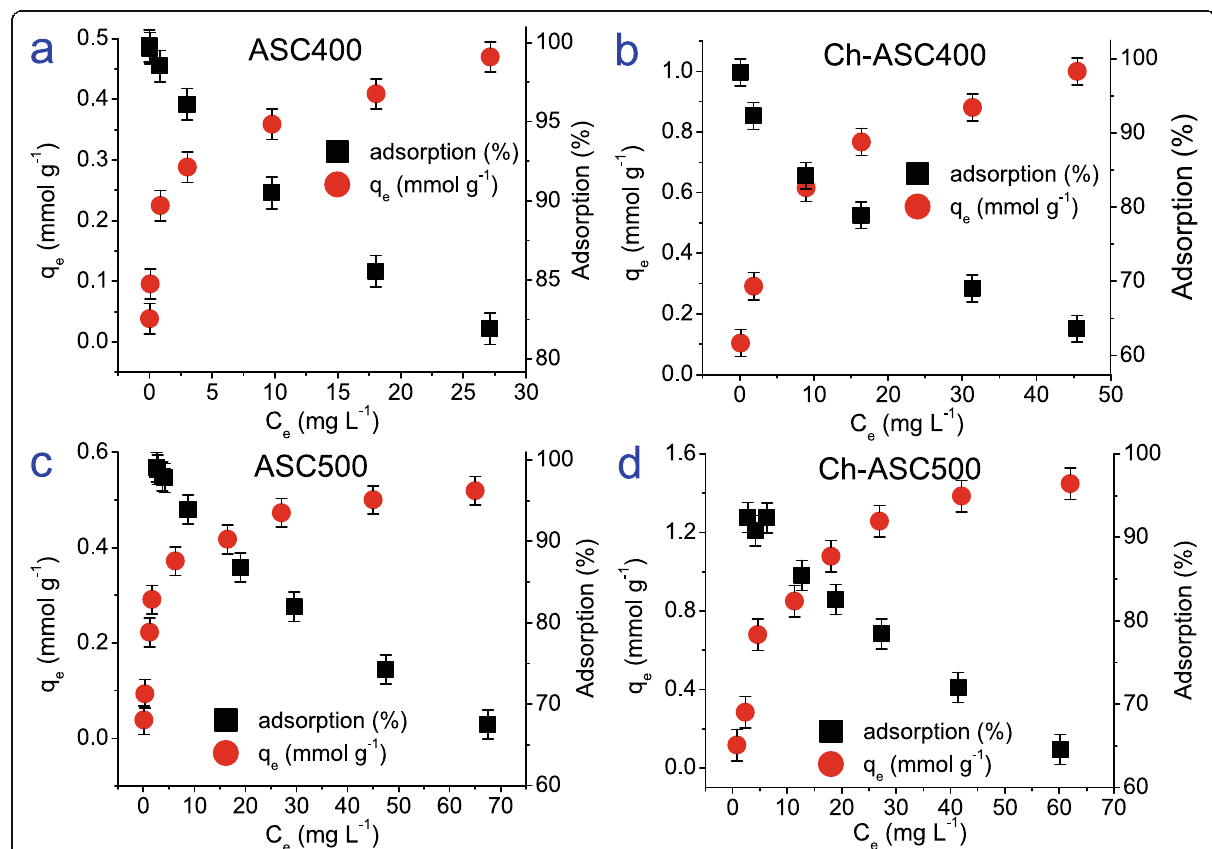
Fig. 8 Effect of initial Cr(VI) concentration on Cr(VI) adsorption; a for ASC400, b for Ch-ASC400, c for ASC500 and d for Ch-ASC500 (adsorption conditions: adsorbent dosages: 5.0 g L − 1 for ASC400 and ASC500, 1.5 g L − 1 for Ch-ASC400 and Ch-ASC500; contact time: 120 min; pH: 1.5; temperature: 25